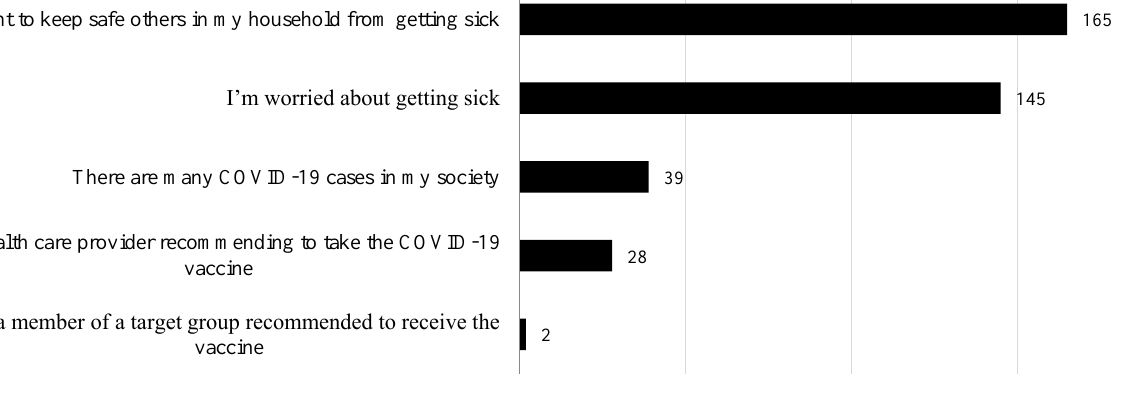
Figure 1. Parental reasons for accepting to vaccinate themselves or one of their family members with a COVID-19 vaccine .